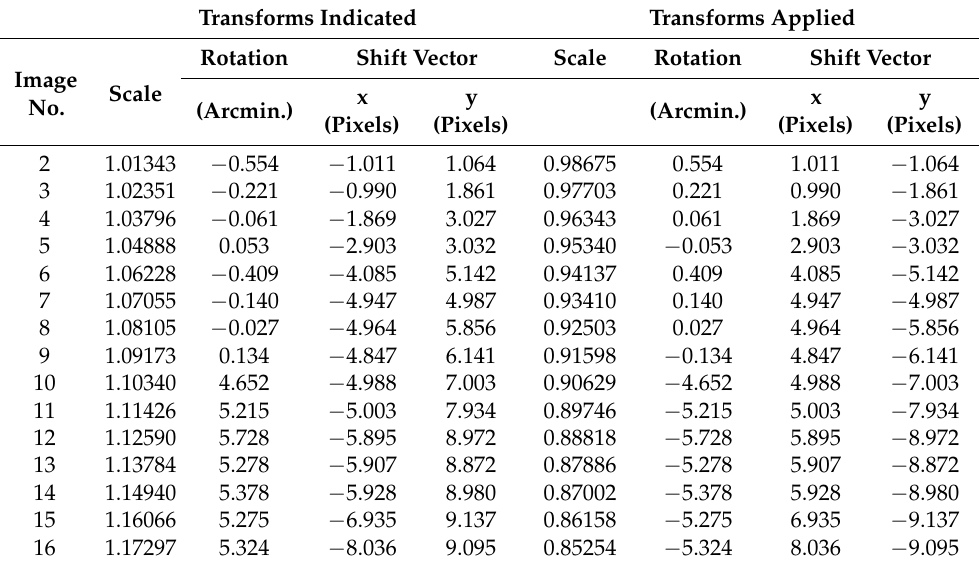
Table 1. Parameters of the transforms indicated and applied to separate images in the series of blue marble series (stated relative to the first image). Taken from